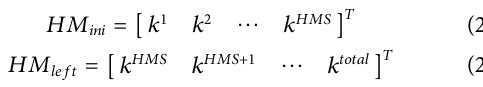
Frontiers in Energy Research |